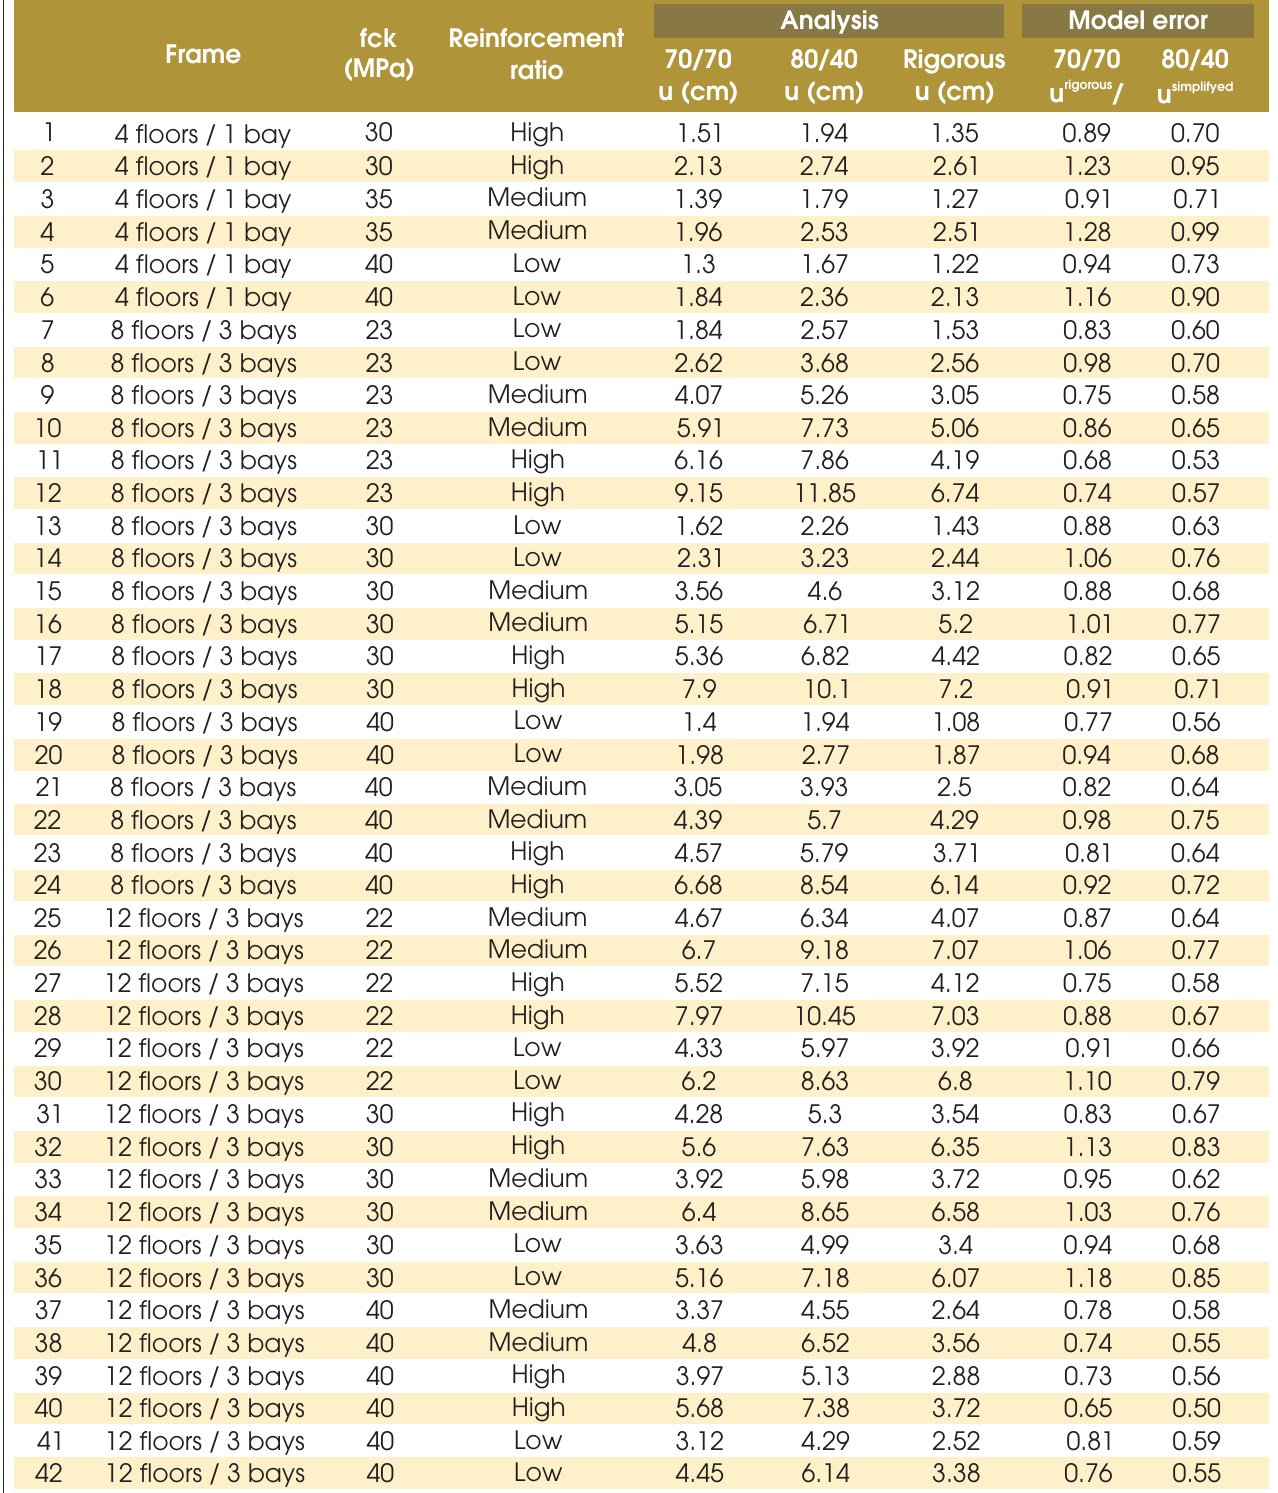
Table 1 – Evaluated horizontal displacements and model error